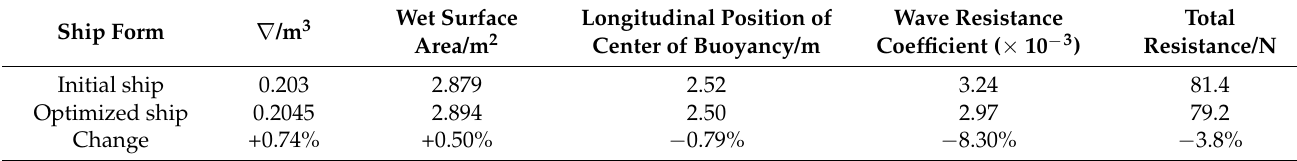
Figure 12. Optimization results. Table 12. Hydrodynamic data.